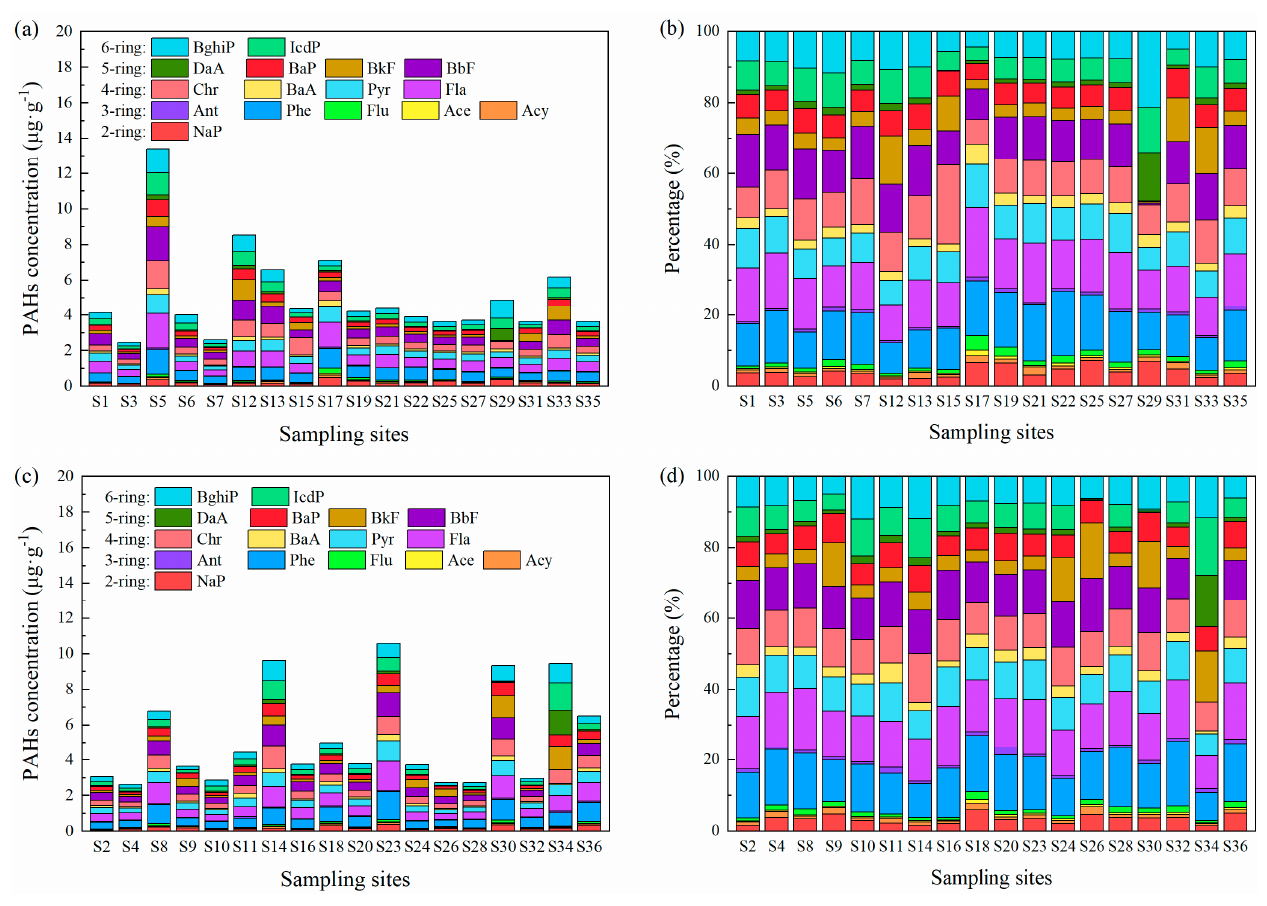
Figure 2. Concentration and percentage of individual PAH for each site: ( a ) concentration of PAH in libraries; ( b ) percentage of individual PAH in libraries; ( c ) concen tration of PAH in dormitories; ( d ) percentage of individual PAH in dormitories.